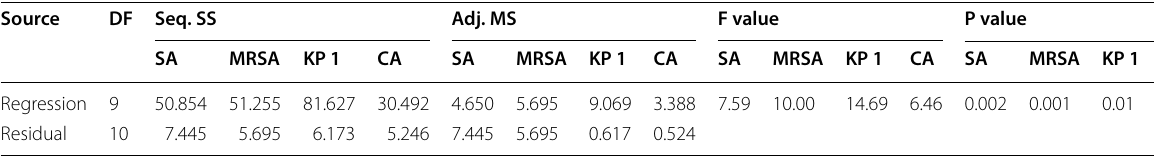
DF degree of freedom, SS sum of squares, MS mean square; R2